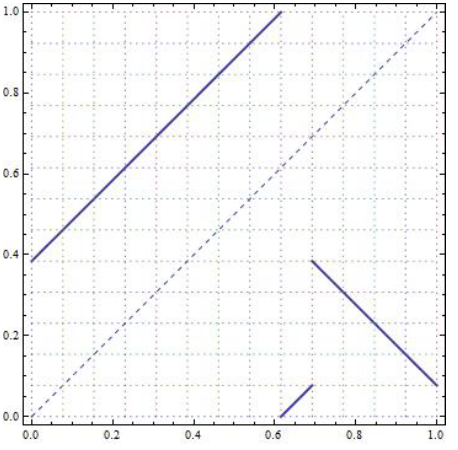
Figure 13. The graph of a ( 3,1 ) -IET with permutation ( 3,1, − 2 ) and λ = ( 8,1,4 )